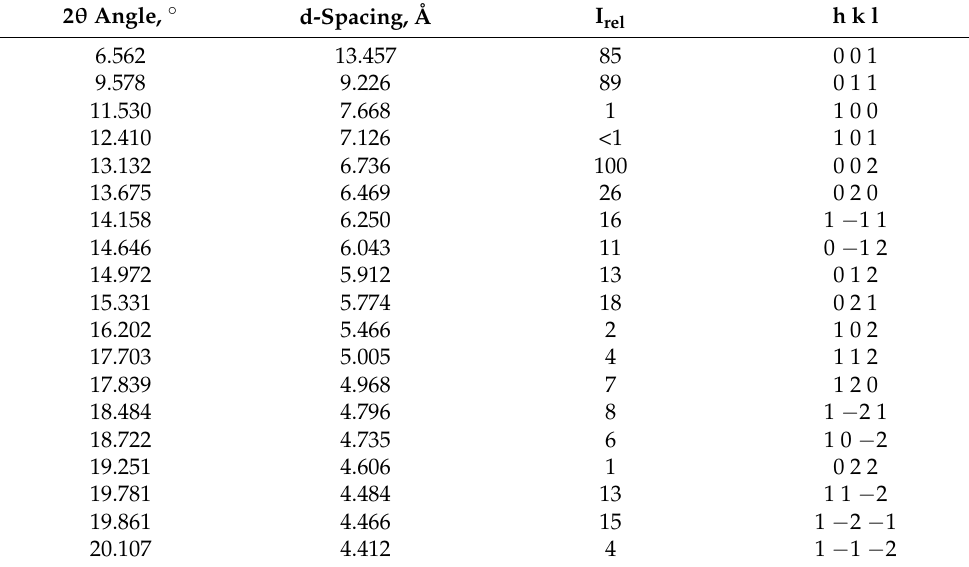
Table 9. List of observed 2 θ angles, d-spacings, and relative intensities, jointly with reflection indices, for Eltrombopag DMA